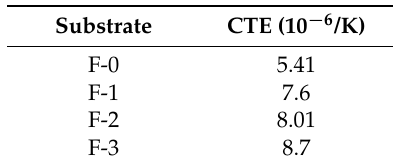
Table 3. CTEs of the composite